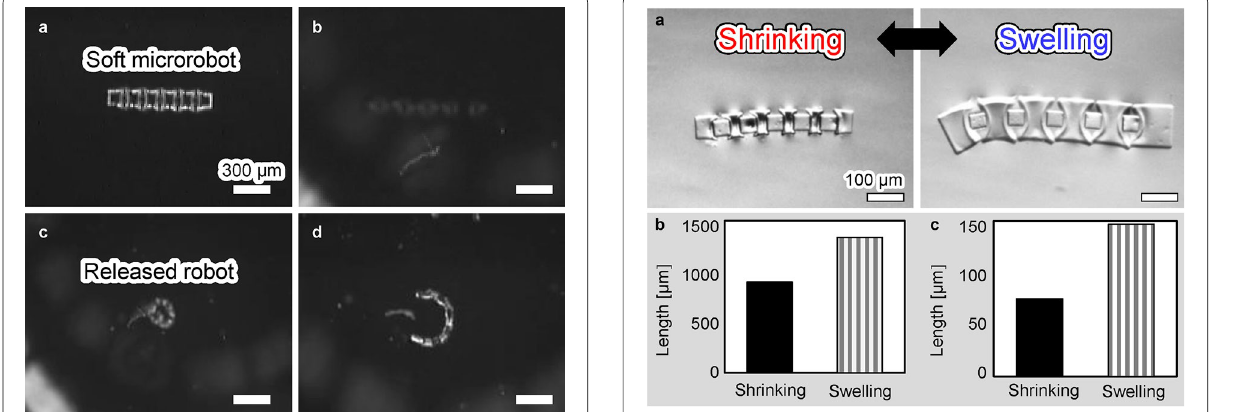
Fig. 9 Actuation of microrobot via environmental temperature change. a Microscopic image, and size differences in ( b ) total length of the microrobot and c a single actuator part